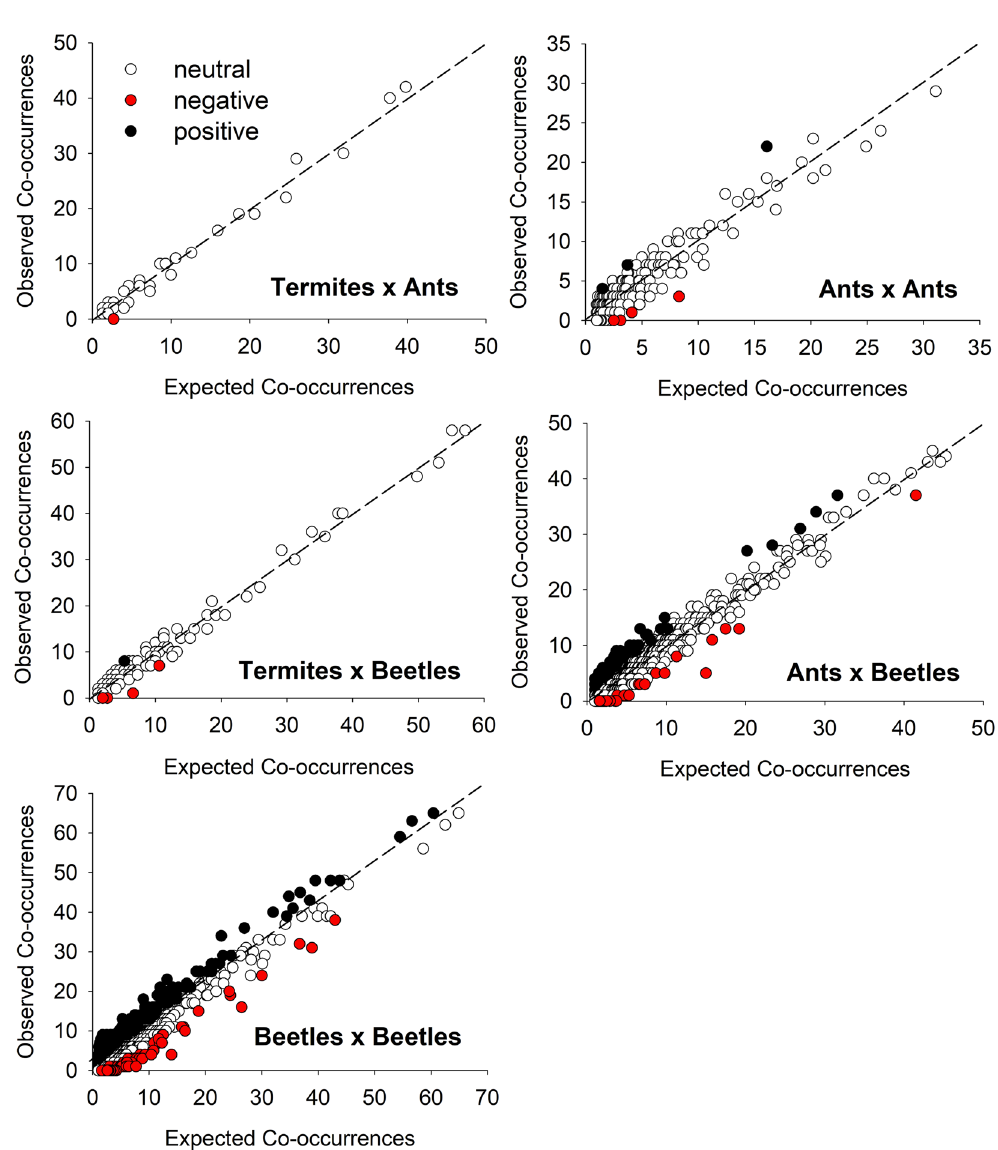
Figure 2. Observed-expected plots showing the relative numbers of positive and negative associations between species pairs based on co-occurrence